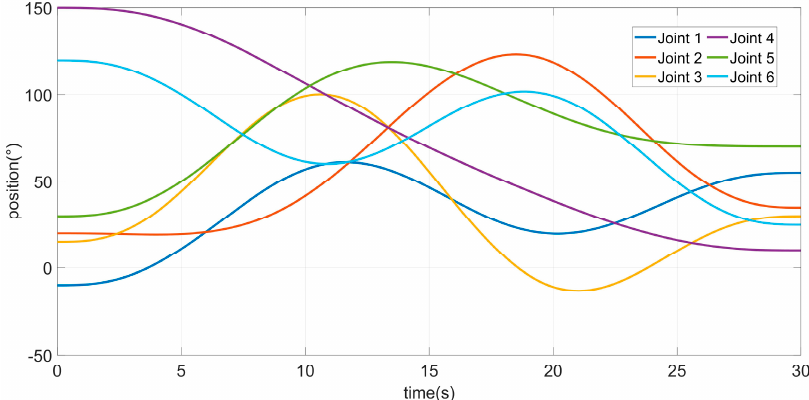
Figure 4. Position curves of all joints by the proposed technique ( T f = 29.9930 s).